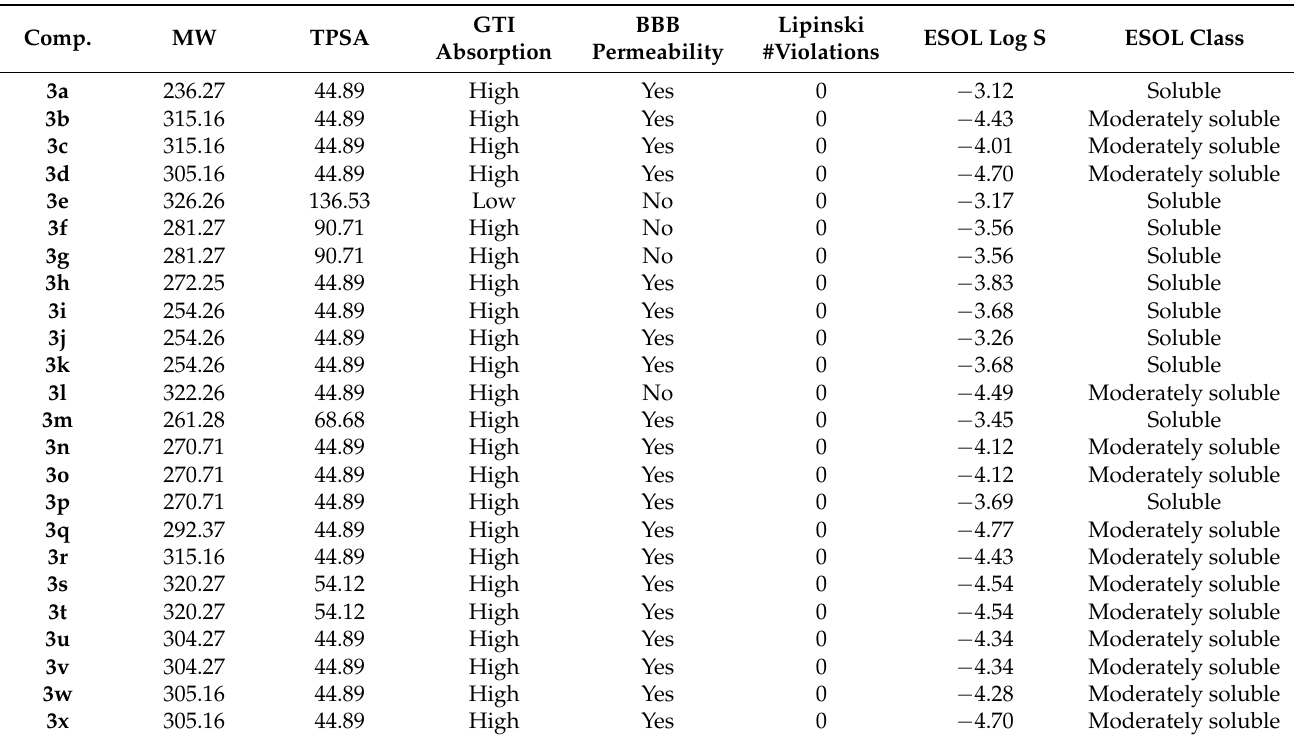
Table 2. Predicted physicochemical, lipophilicity, and drug-likeness properties for compounds 3a – x .